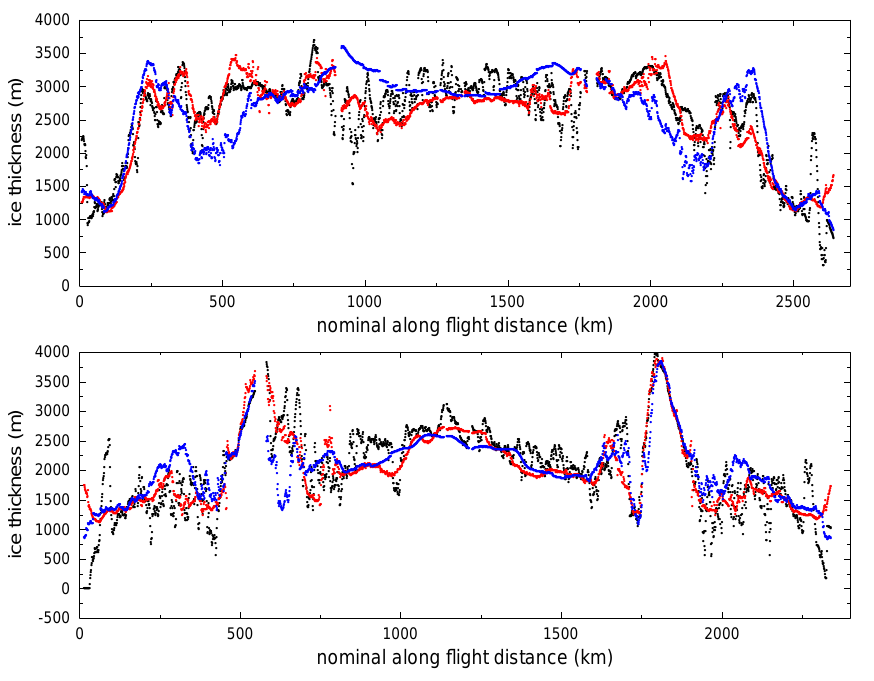
Fig. 4. Comparison between ICECAP ice thickness measurements (black) and predicted ice thicknesses along flight lines R19 (top) and R21 (bottom) from the historical data (Fig. 1a) TELVIS (red) and an inverse-distance-cubed scheme (blue). R19 and R21 are the second most westerly and most westerly pair, respectively, of flight lines shown on Fig. 7a.